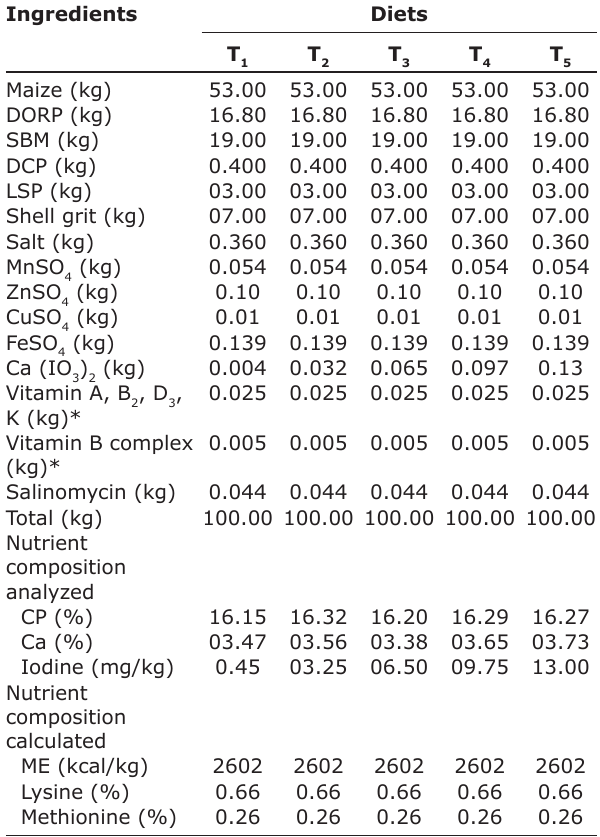
Table-1: Ingredients and nutrient composition of layer diets (%).